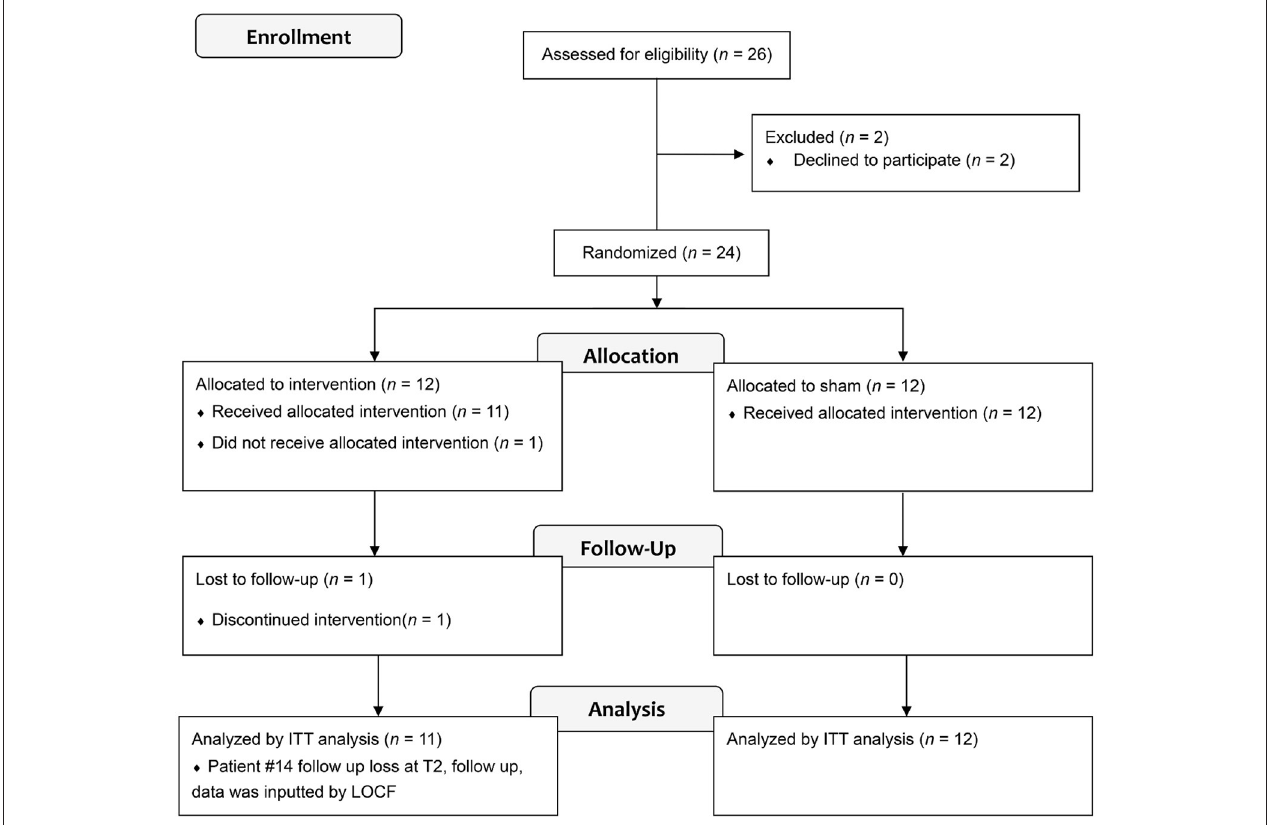
FIGURE 1 | Flow diagram of the